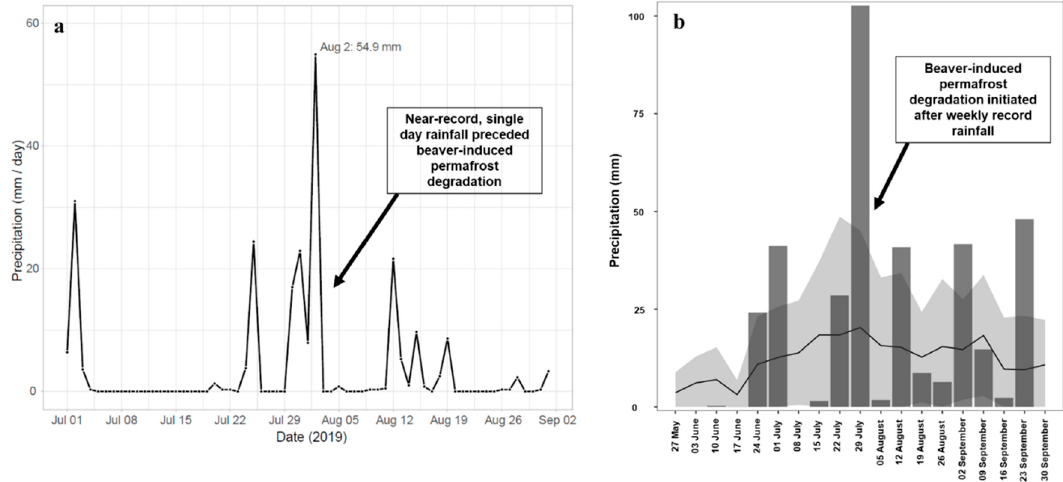
Figure 10. Precipitation data plots based on the US National Weather Service station located in Nome, Alaska. ( a ) Plot of daily rainfall (mm/day) from July and August 2019 showing the extreme precipitation event on 2 August 2019, two days before initial failure of the beaver dam complex was noticed in the PlantLabs, Inc. (Pleasant Grove, CA, USA) satellite imagery (Figure 4). ( b ) Daily precipitation data aggregated into weekly bins showing the weekly summer rainfall during 2019 (dark grey bars), the mean weekly rainfall (black line) and the standard deviation (light grey shaded area) in weekly rainfall for the 15-year period from 2006 to 2020. The nine days prior to the failure of the beaver dam complex and initiation of the permafrost degradation feature were the highest on record during the period of beaver occurrence in the Swan Lake Creek study